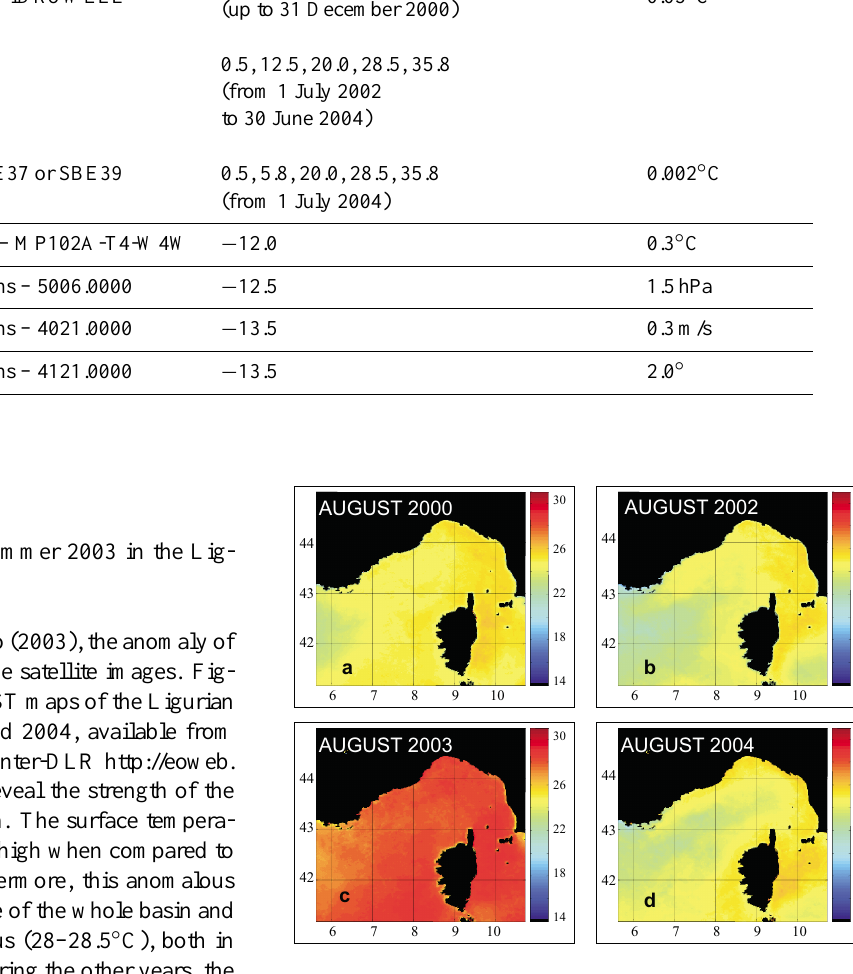
maximum of 26.8 ◦ C was observed. In summer 2002, the sea surface temperature is always less than 26 ◦ C, reaching a maximum value of 25.5 ◦ C on 25 July. Even if data are not available from 25 August to 11 September 2004, we can con- clude on the basis of available data that, on average, the sea surface temperature was lower than in 2003 in this case